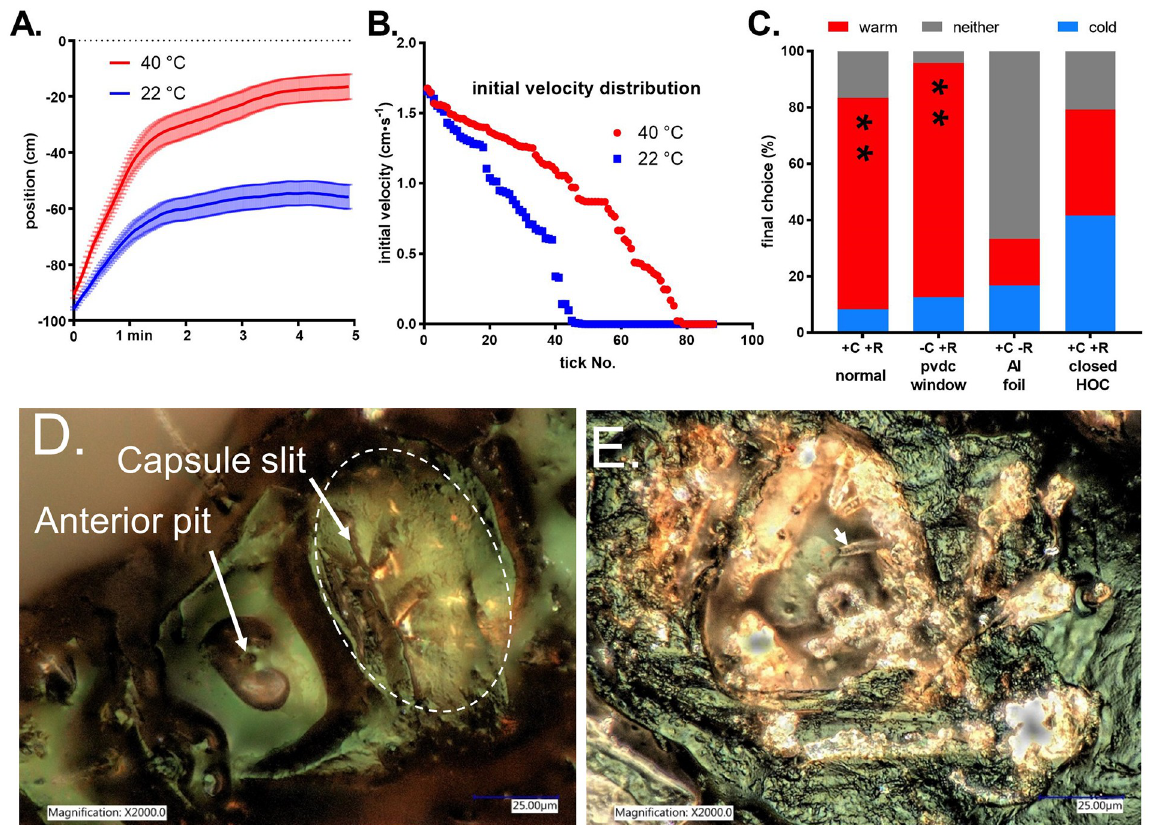
Fig 6. Sensitivity and mechanism of tick heat sensing. A. Mean longitudinal position ( ± SEM) over time (s) of 88 A . americanum females (measured in 11 groups of 8) after placement adjacent to the cold end wall at -100 cm with respect to the target wall, which was set to either 22 or 40 ˚C. B. Distribution of initial velocities of all 88 ticks tested at 22 or 40 ˚C, averaged over the first 10 s, from fastest to slowest. C. Final choice scores in thermotaxis trials of A . americanum females placed in the center of the arena, with the target at 40 ˚C, under normal conditions, where convection and radiation from target to ticks are both possible (+C +R, normal), with an IR-transparent PVDC film barrier 5 cm from each end wall to block any possible convective air currents (-C +R, PVDC window), with both end walls clad with aluminum foil to eliminate radiant heat emission and leave only the possibility of heat transfer by convection (+C -R, Al foil), and finally in the normal arena but with both Haller’s organ capsule apertures closed with paraffin wax (+C +R, closed HOC). ( �� = p < 0.001 for warm/cold difference). D. Female A . americanum Haller’s organ viewed with epi-illumination shows hints of reflected light through the capsule aperture. Approximate outline of the capsule is shown by dashed oval. E. Interior surfaces of the Haller’s organ capsule and cover debris appear highly reflective after cover removal with an ultrasonic micro-etcher, but thin-walled sensilla (white arrowhead) are not